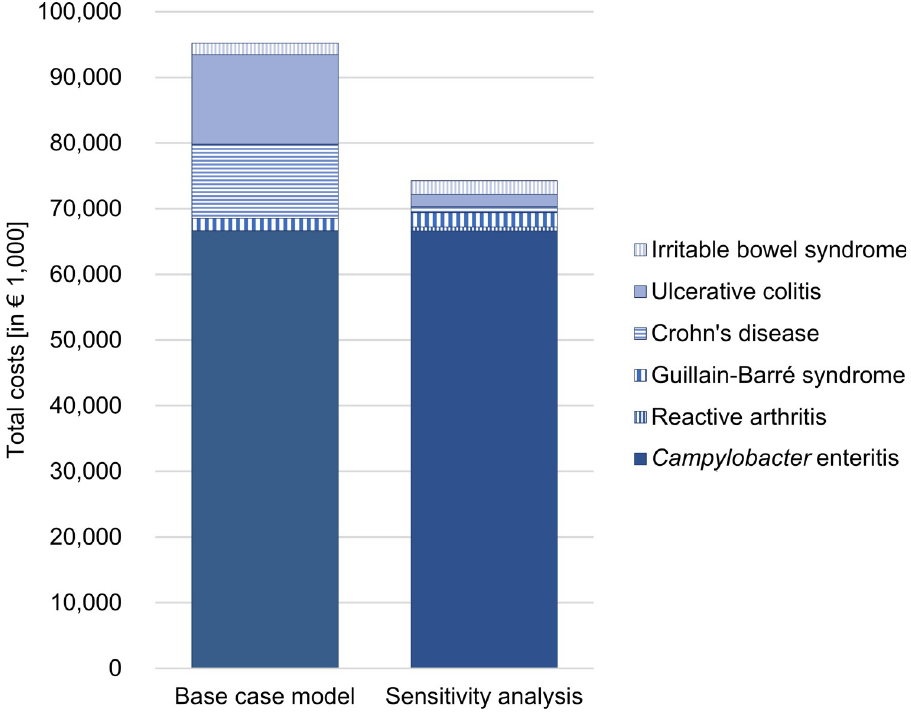
Fig 4. Extrapolated total costs associated with Campylobacter enteritis cases in 2017 including sequelae in Germany. Extrapolation is based on Campylobacter enteritis cases, hospitalizations and deaths as officially reported for Germany in 2017 [2, 36, 37]. In the sensitivity analysis, the frequencies of sequelae according to published meta- analyses [38, 39] were used. Total costs were estimated by Monte Carlo simulation with 10,000 iterations.